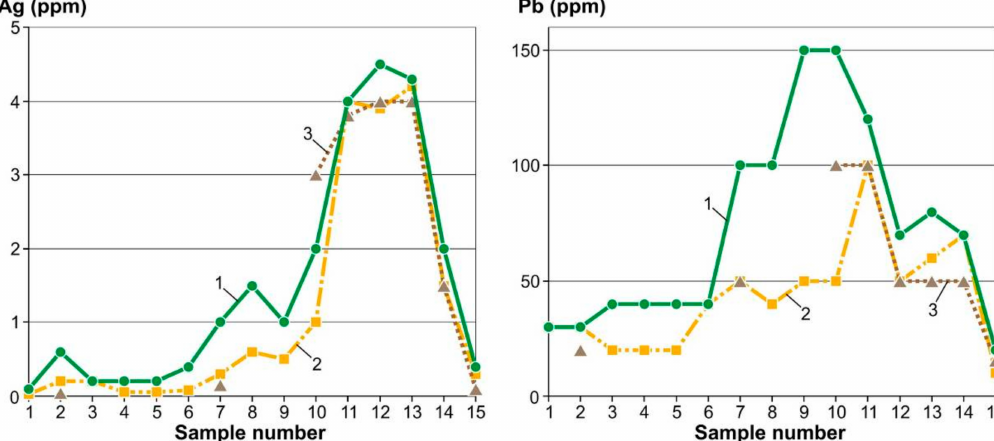
Figure 12. The Goltsovy Ag – Pb deposit. Ag and Pb contents in samples taken along the I-order watercourse (Pryamoy stream): 1—bryolithochemical, 2—lithochemical from the moss cushion, and